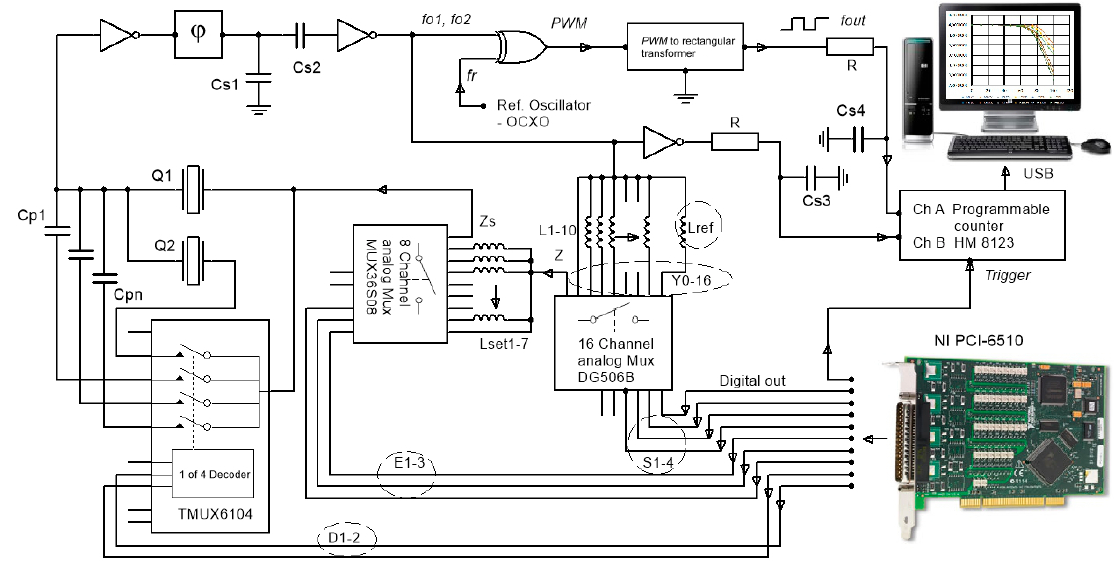
Figure 3. Automated inductance converter principle.